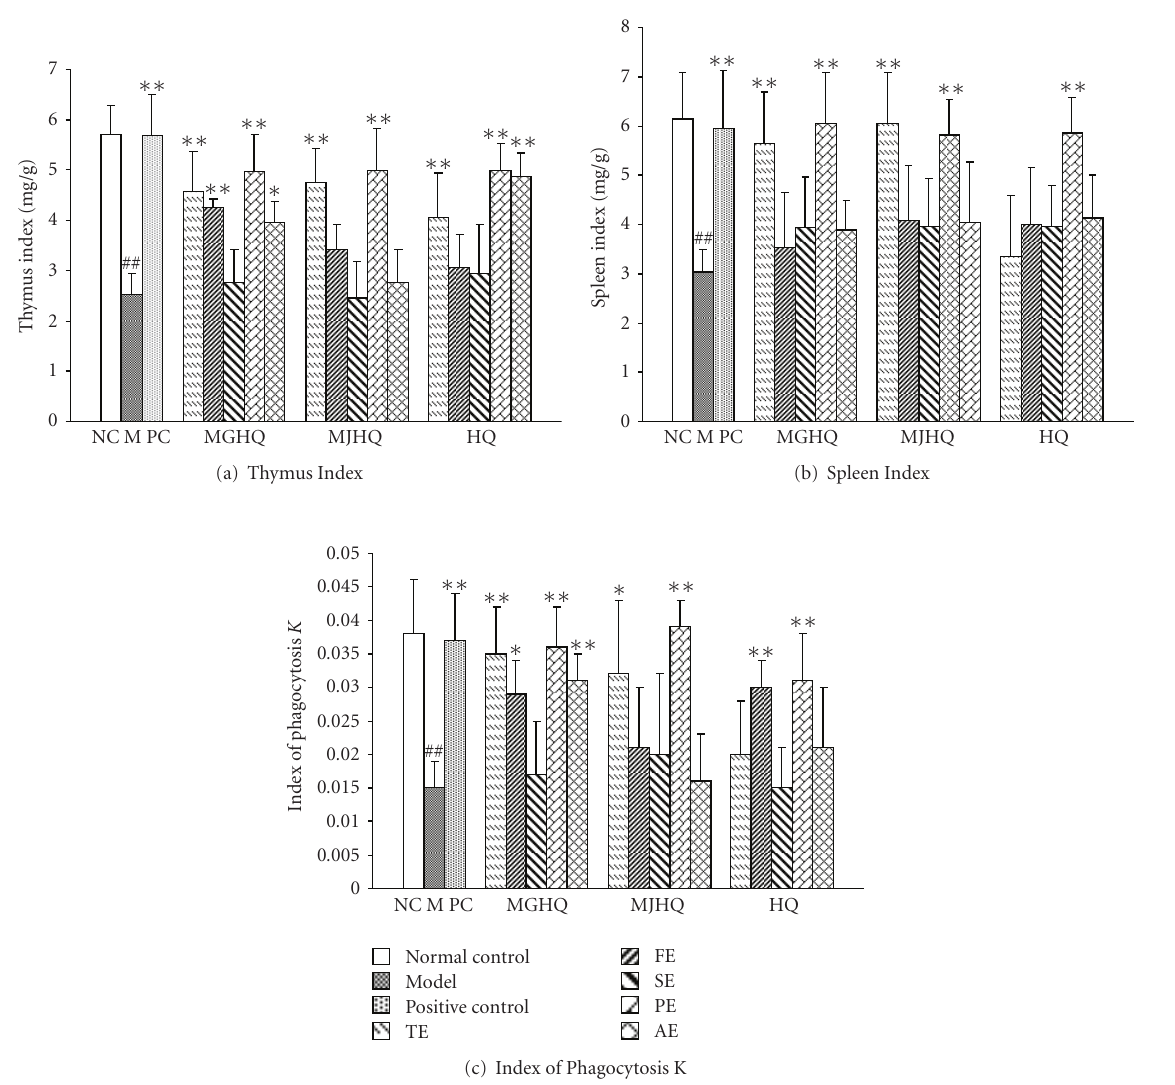
Figure 4: E ff ects of di ff erent extracts on mice immune organs and phagocytosis ## P < . 01 and # P < . 05 versus the normal control group. ∗∗ P < . 01 and ∗ P < . 05 versus the model